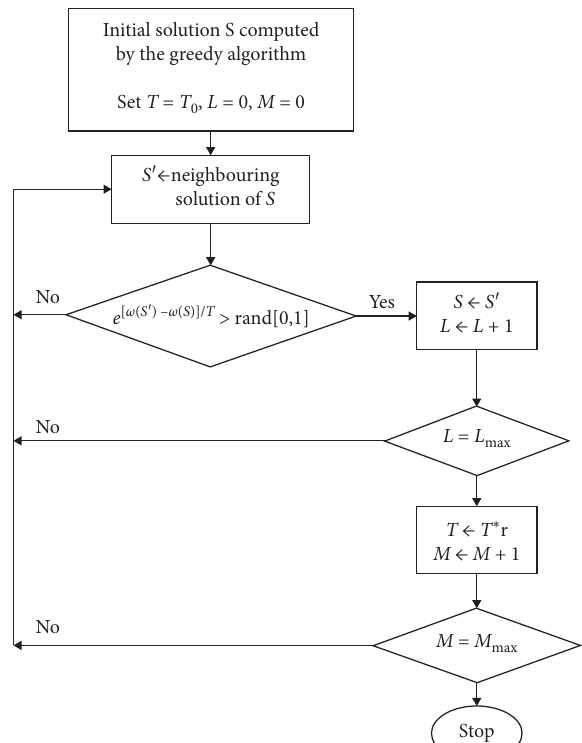
Figure 1: Simulated Annealing algorithm flow chart.